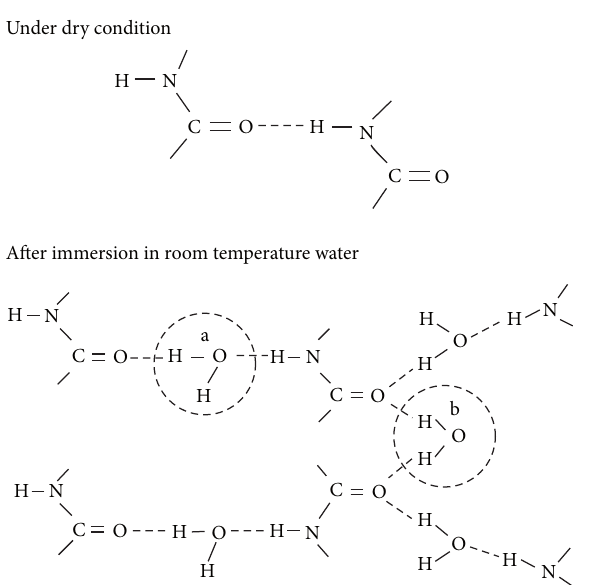
Figure10:Effectsofwateronthehydrogenbondinginpolyurethane SMP [27].